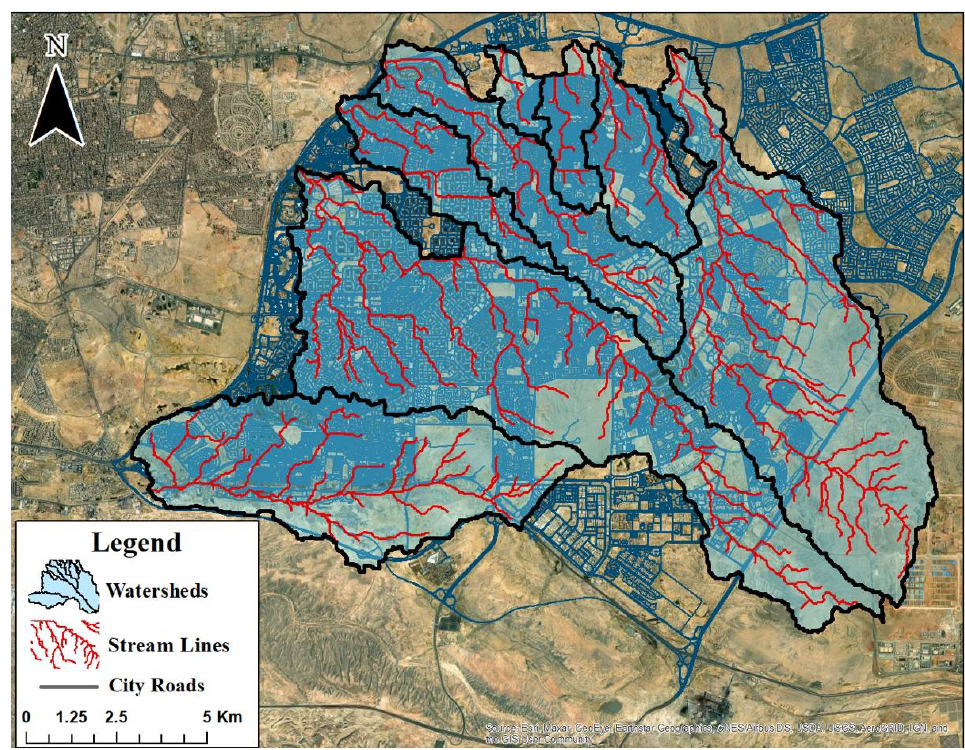
Figure 6. Previous watershed passed through New Cairo before urbanization. Currently the natural streamlines are totally blocked due to the land use changes.